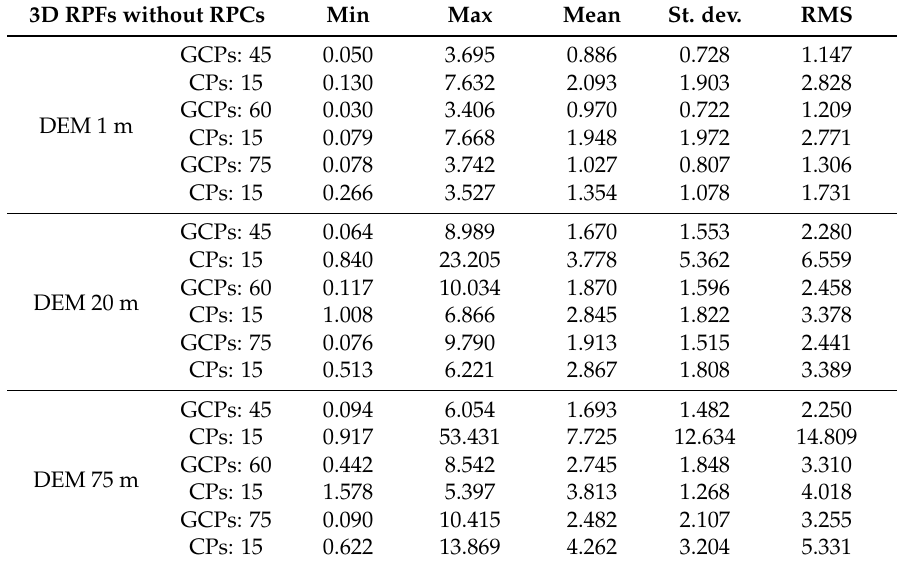
Table 5. Residuals (in meters) obtained for GCPs (45-60-75) and CPs using RPFs without RPC file. 3D RPFs without RPCs Min Max Mean St. dev.